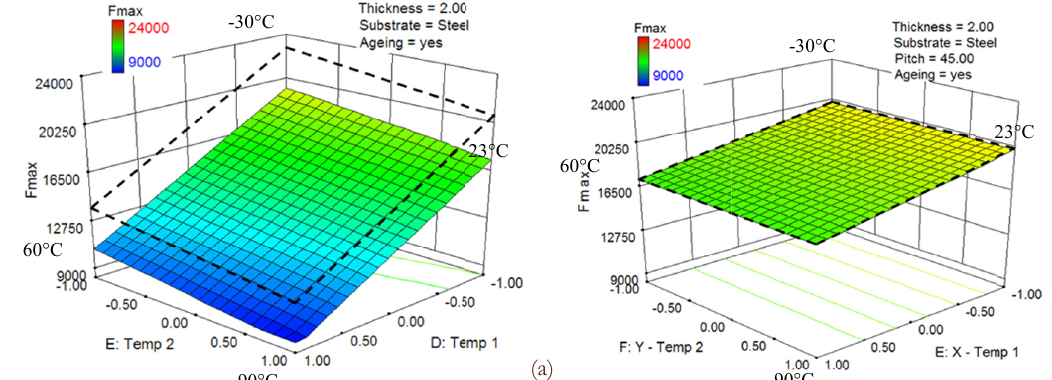
Figura 1 14: Effetto del